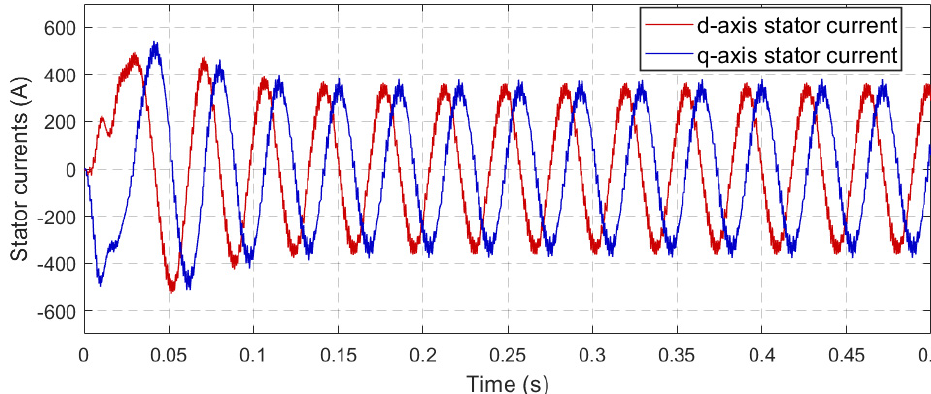
Figure 11. d–q-axis stator currents, (0,0.5 s).